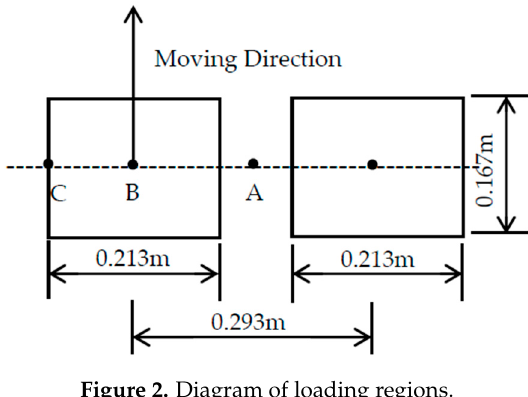
Figure 2. Diagram of loading regions.